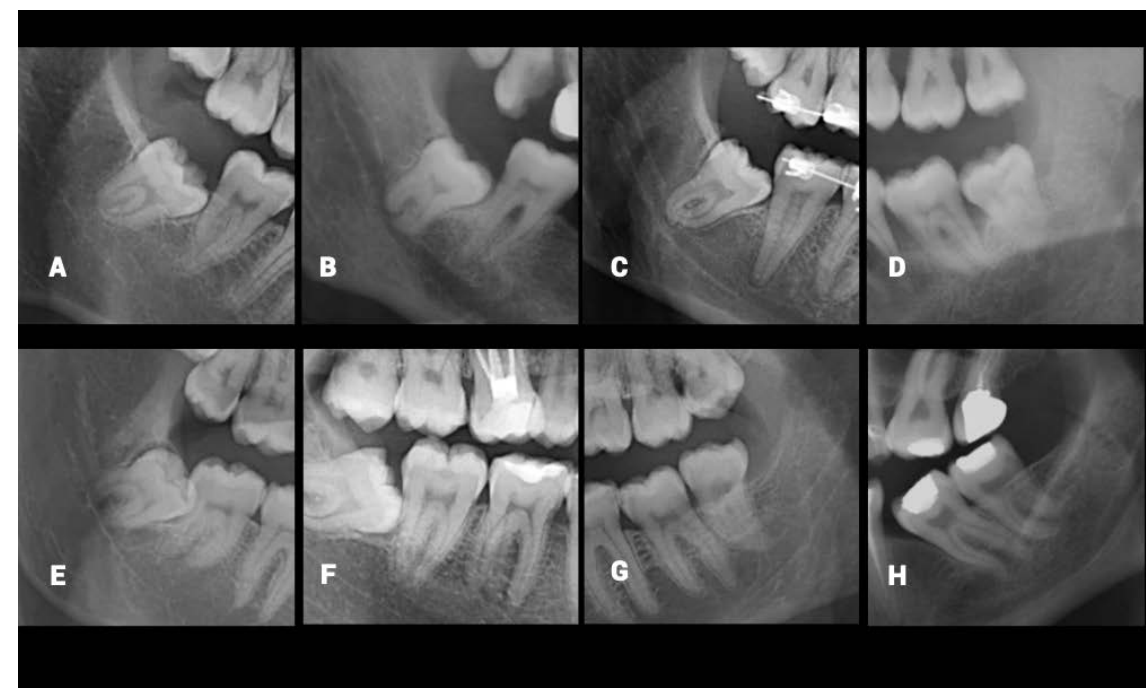
Figure 3. Examples of the misclassified mandibular canal and mandibular third molar overlap by the algorithm and the possible characteristics that cause misclassification: ( A ), Ill-defined superior border of MC; ( B ), Narrowing of the MC; ( C ), Dilacerated root morphology of M3; ( D ), The ghost image of the opposite inferior border of mandible; ( E ), Superimposition of the lateral border of the tongue; ( F ), Failed segmentation; ( G ), Bifid MC; ( H ), Superimposition of the mylohyoid ridge.